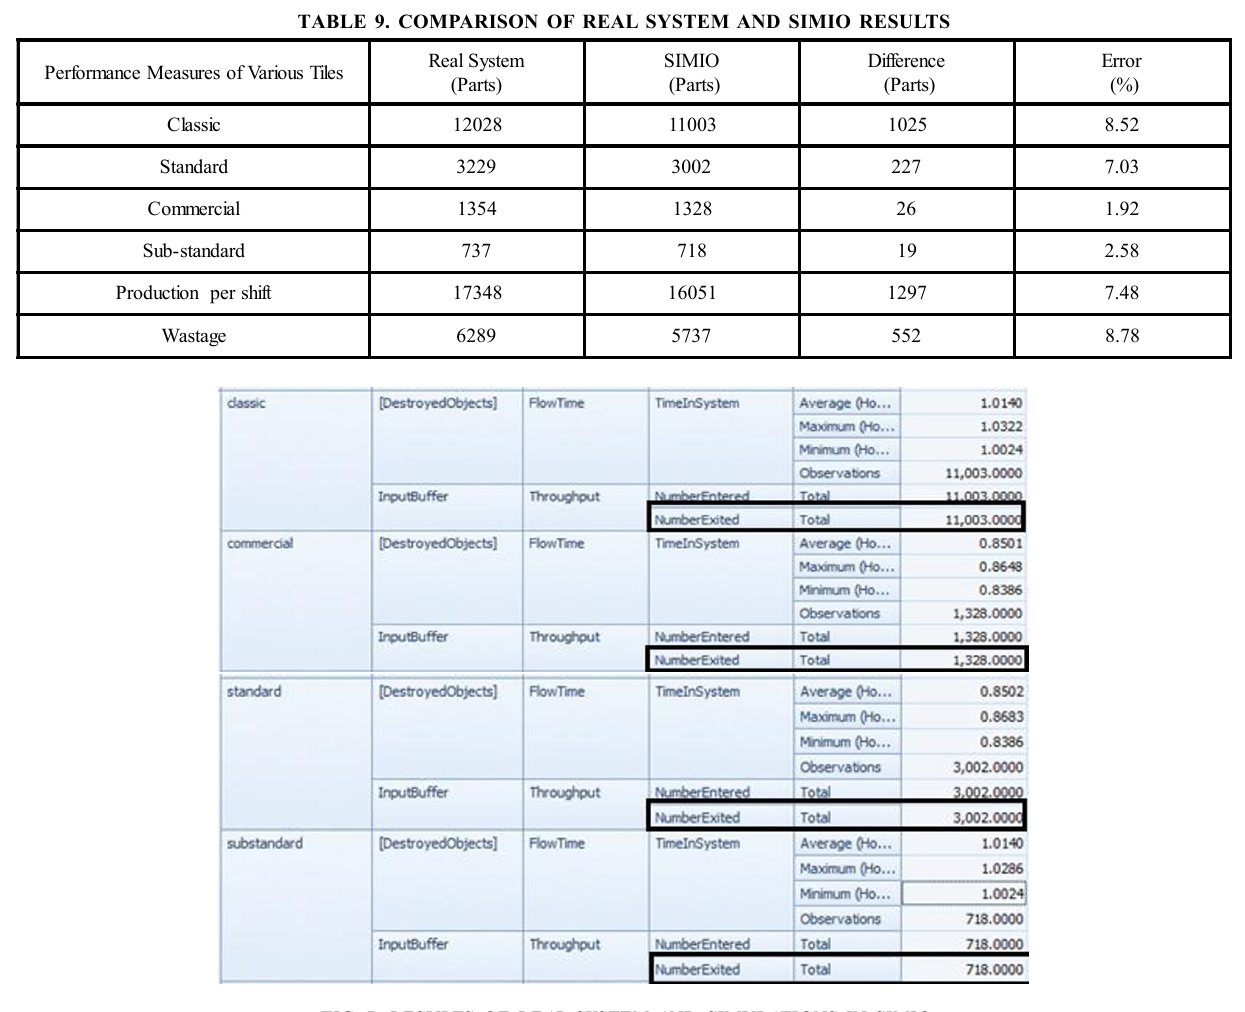
FIG. 7. RESULTS OF REAL SYSTEM AND SIMULATIONS IN